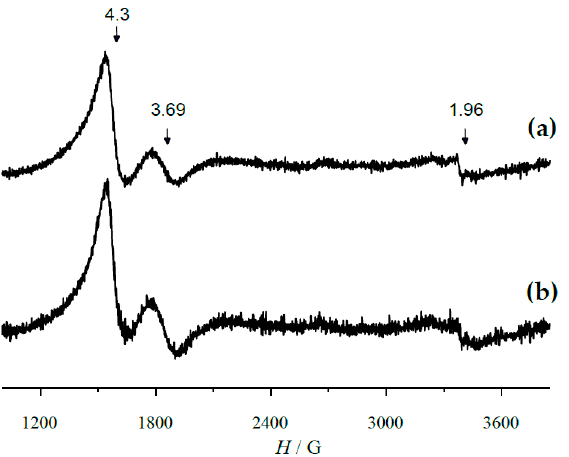
Figure 4. EPR spectrum ( − 196 ° C) of the catalyst system 2 /H 2 O 2 /AA = 1:3:10 ([ 2 ] = 0.02 M) in a 1:1.8